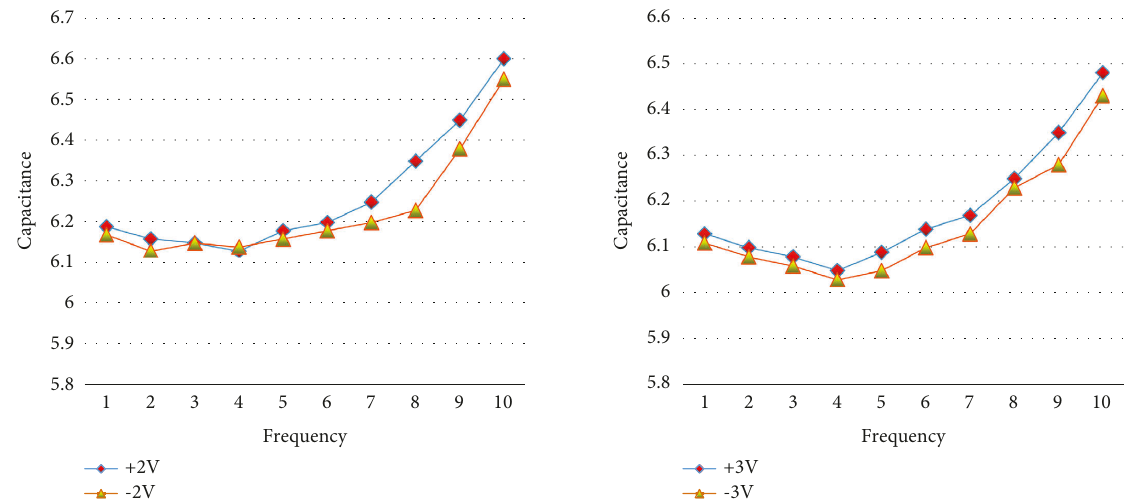
Figure 12: Comparison diagram of the device performance at different